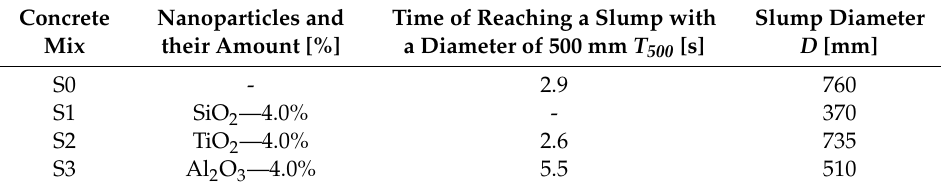
Table 3. Rheological properties of self-compacting concrete mixes (based on [22]). Concrete